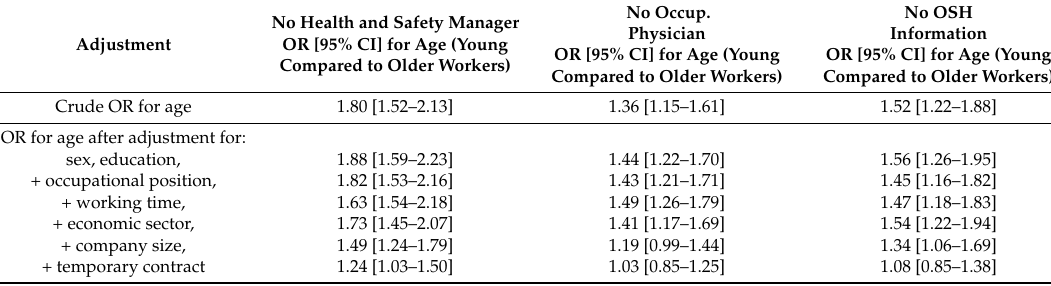
Table 3. Age-differences in OSH service access after adjustment for employment conditions. Results of the logistic regression comparing young workers with workers aged 30–64 (reference), stepwise adjustment for covariates starting with a model adjusted for sex and education (odds ratios (OR) [95% confidence interval,